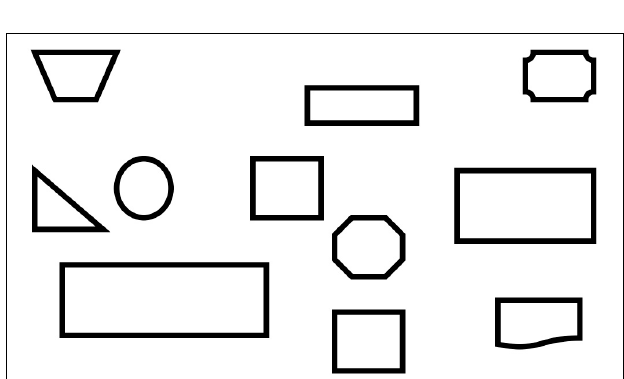
FIGURE 3 | A sample item of rectangle recognition from the shape recognition task.